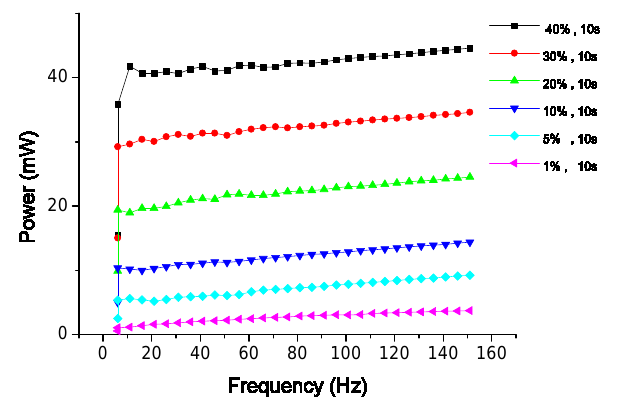
Figure 6. Optical power versus frequency at 1 cm distance between source and detector, with 500 mA bias (125 mA to each LED) for different duty cycles over 10 s integration time.